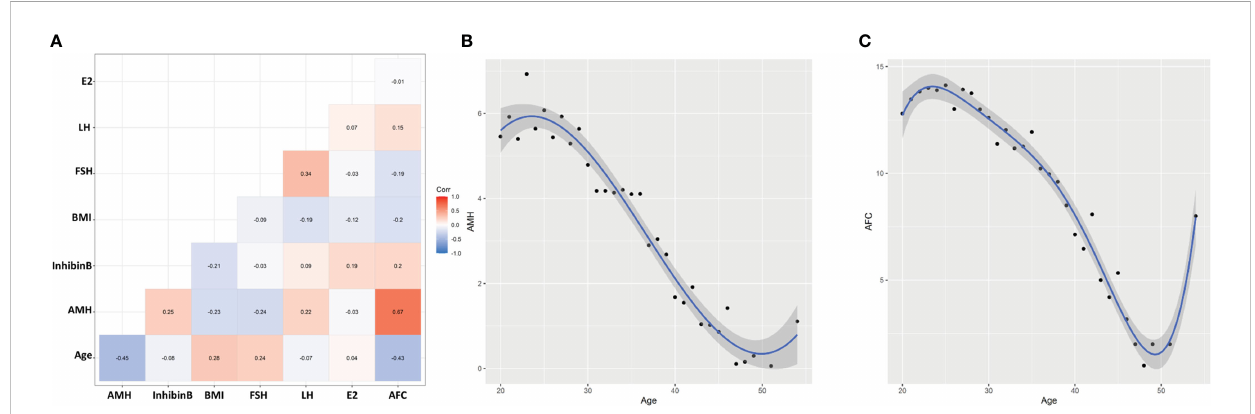
FIGURE 2 Correlation and distribution between features and age. (A) Pearson ’ s correlation coef fi cients between age and different features. (B) Age-speci fi c anti-Müllerian hormone (AMH) value distribution and fi tting curve. (C) Age-speci fi c antral follicle count (AFC) value distribution and fi tting